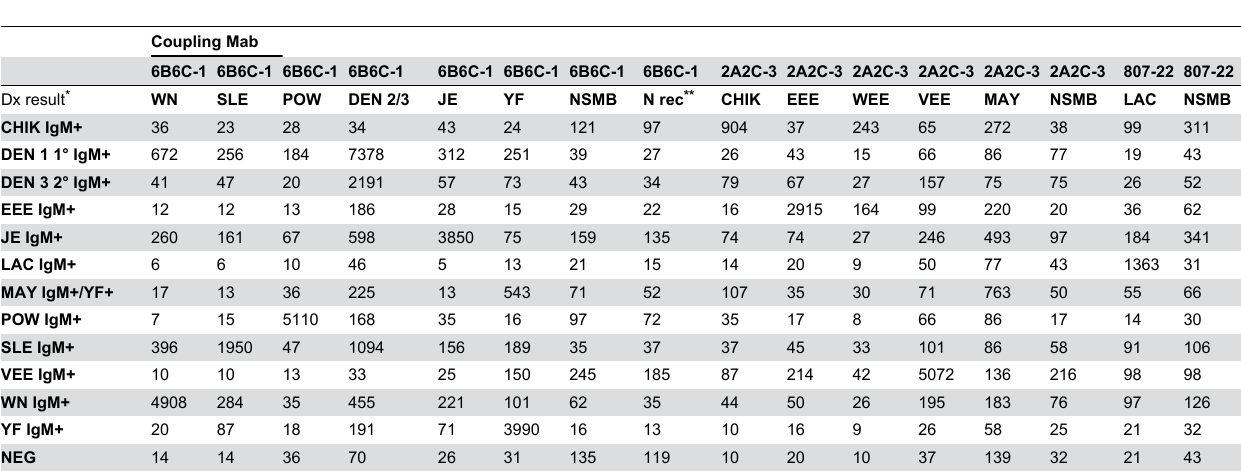
Table 3. Median fluorescent intensities (MFIs) on each antigen for selected samples tested in the IgM multiplex MIA.